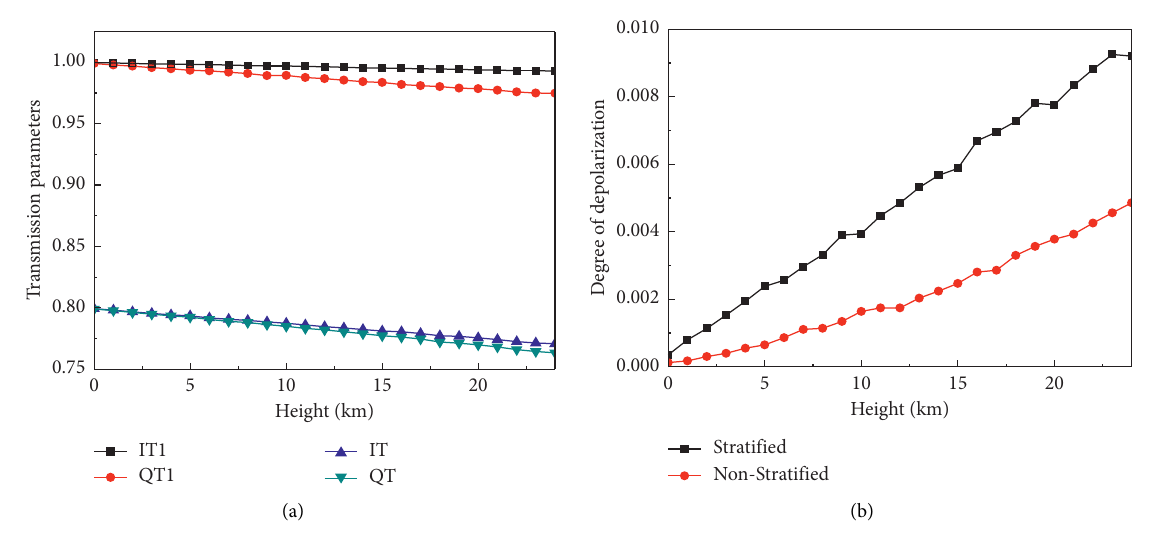
Figure 7: Variation of polarization parameters (stratified and nonstratified) with height ( b � 0.1 μ